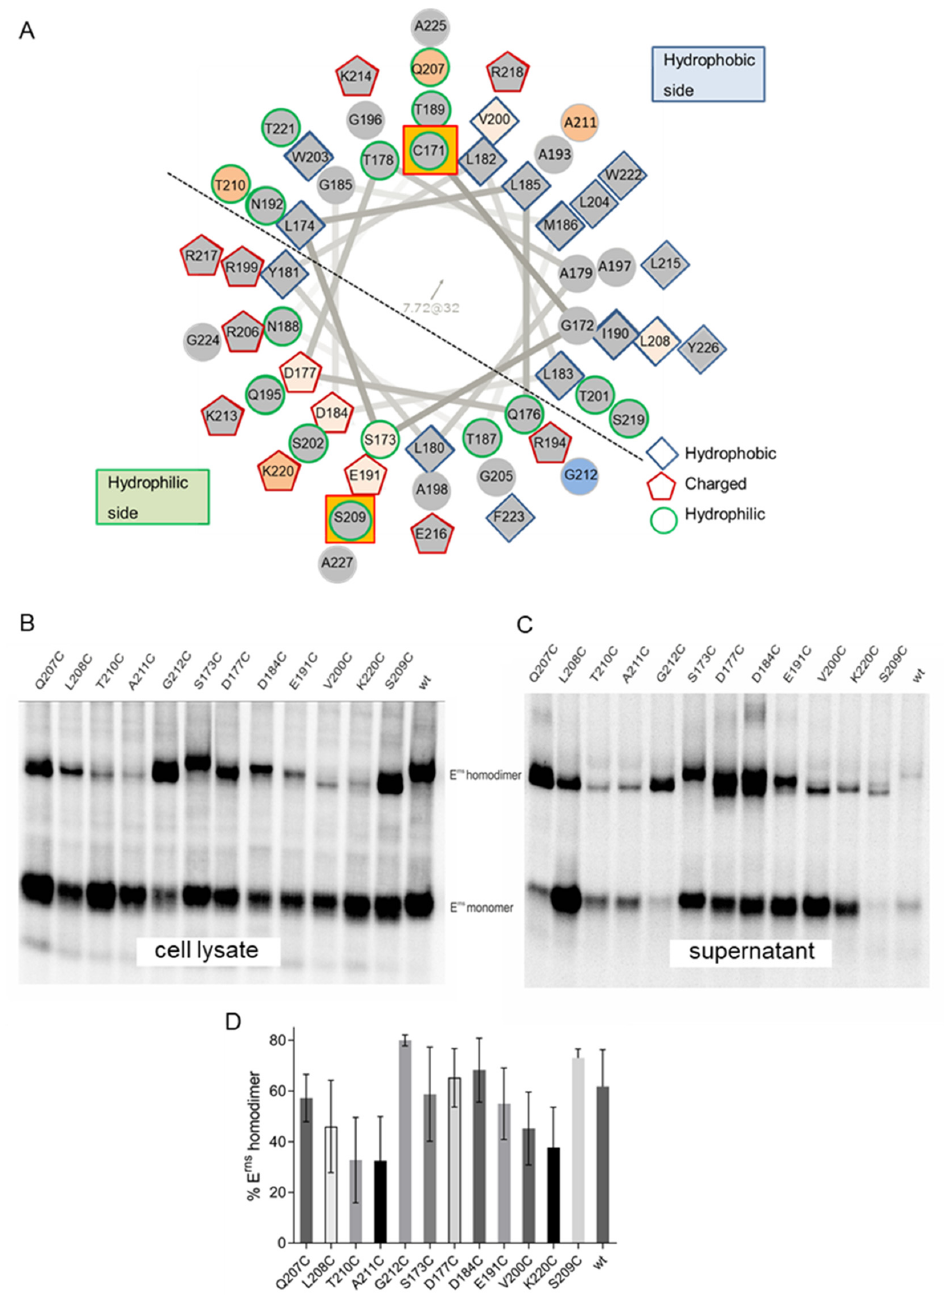
Figure 3. Disulfide bond formation can occur between various Cys residues introduced into the E rns membrane anchor region. ( A ) Helical wheel representation of the E rns membrane anchor region from amino acid C171 to the carboxy-terminal A227 (original scheme established using software http://rzlab.ucr.edu/scripts/wheel/wheel.cgi (accessed April 2015), subsequently edited by hand). Hydrophobic, uncharged hydrophilic and charged amino acids are highlighted as indicated. A dotted line indicates the location of the hydrophobic and hydrophilic sides of the helix as deduced from biochemical character of the amino acids and the results of NMR analyses [27] (the amphipathic character of this helix is not ideal, so that some polar residues are found on the hydrophobic side and vice versa). The key residues C171 and S209 are highlighted by an orange square. Residues mutated in experiments presented in sections ( B – D ) are indicated by a colored instead of grey background of the symbol, with darker orange for positions at which mutation leads to decreased dimerization, and a blue background for position 212 showing enhanced dimer formation. Please note that